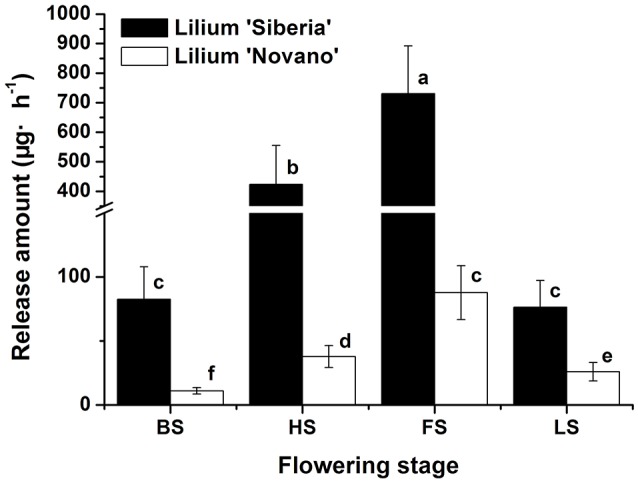
The total amount of floral scent emitted from Lilium ‘Siberia’ (Hu et al., 2016) and Lilium ‘Novano’. Each bar is the average of three independent biological replications, and standard errors are shown. Statistical significance [least significant difference (LSD)] of the difference in the amount of floral scent released is indicated by different small letters (P < 0.05).